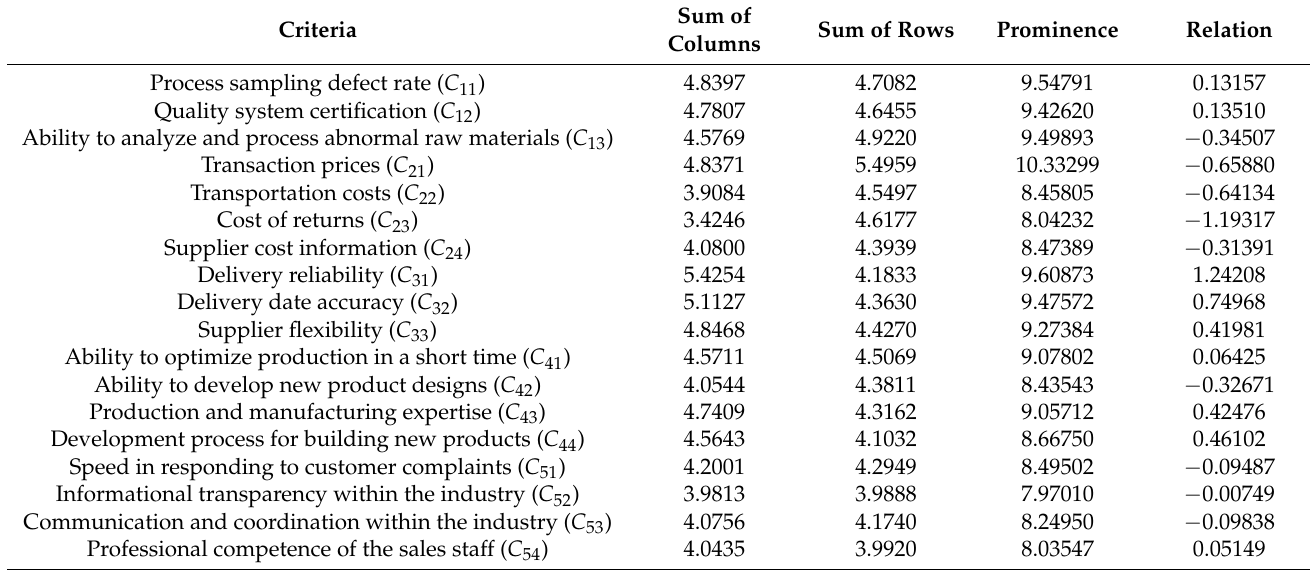
Table 7. Prominence and relation among the